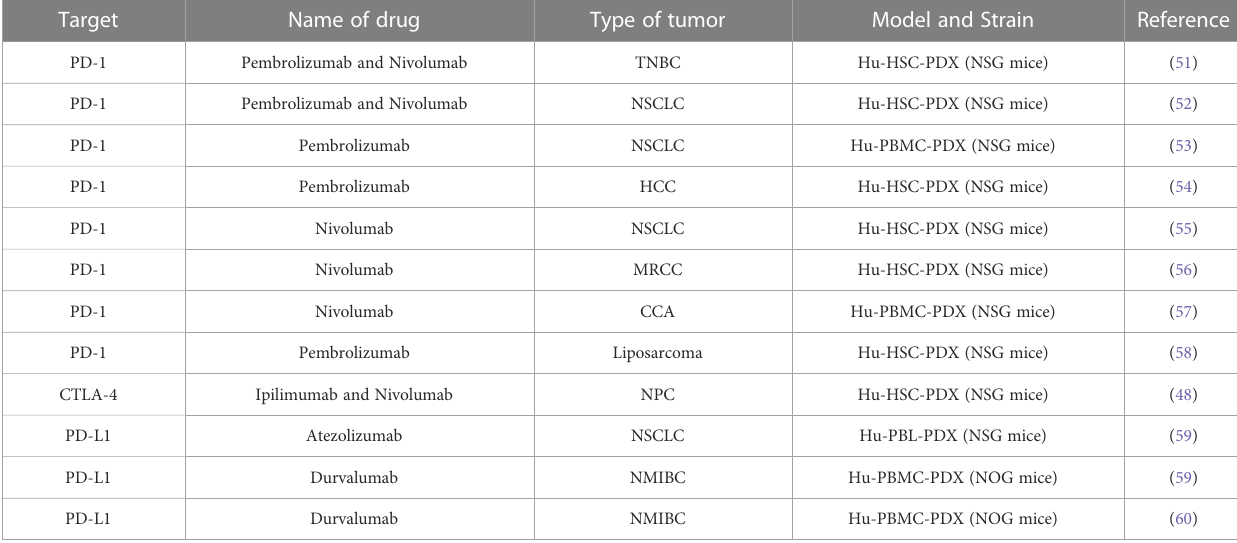
TABLE 1 Patient-derived tumor xenografts (PDX) models in preclinical evaluation of immune checkpoint monoclonal antibody drugs. Target Name of drug Type of tumor Model and Strain Reference